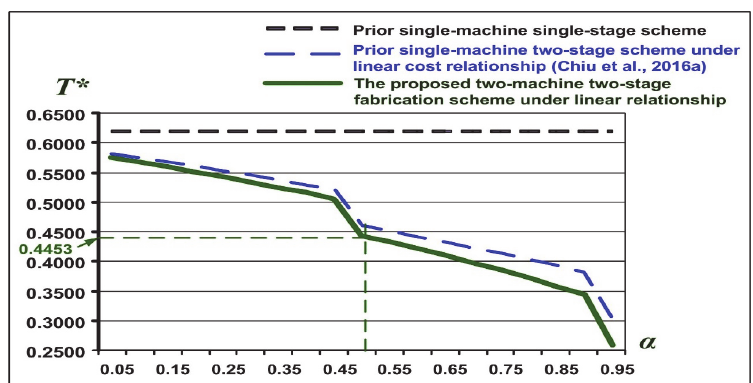
Fig. 8. Performance of T* with respect to α for both single- and two-machine fabrication schemes 3.2. Case 2: assuming nonlinear relationship between cost related parameters and